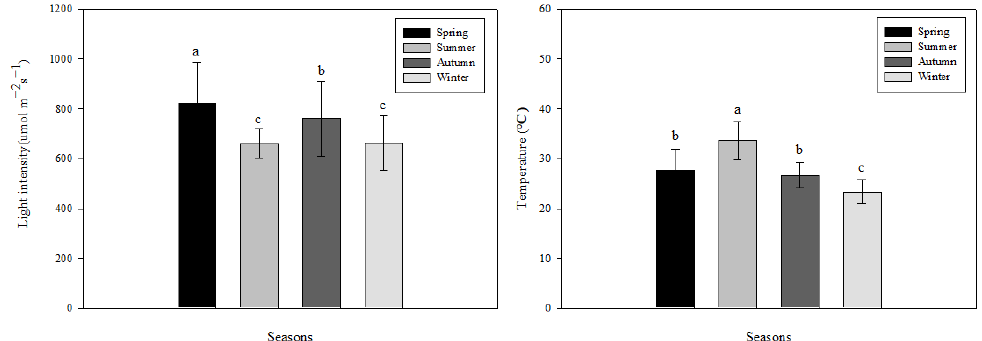
Figure 1. Light intensity and temperature at noon in the greenhouse used in this study. Vertical bars are standard deviations ( n = 60). Small letters at the data points indicate mean separation between the values by Duncan’s multiple test at p = 0.05.